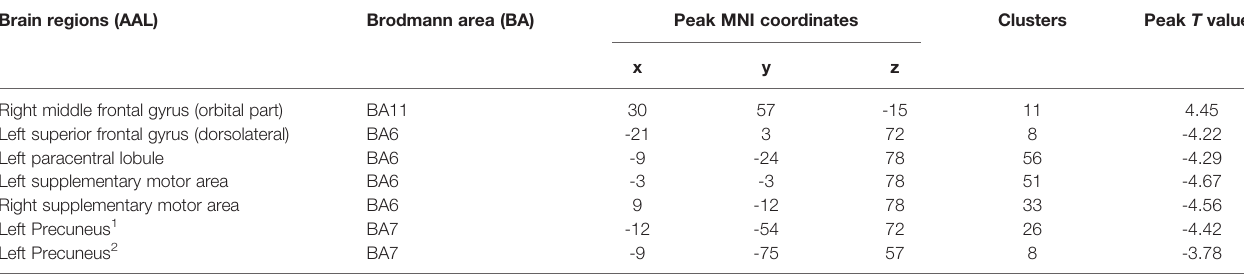
TABLE 2 | Brain regions showed differences in ReHo values between DM-ED and HC groups.